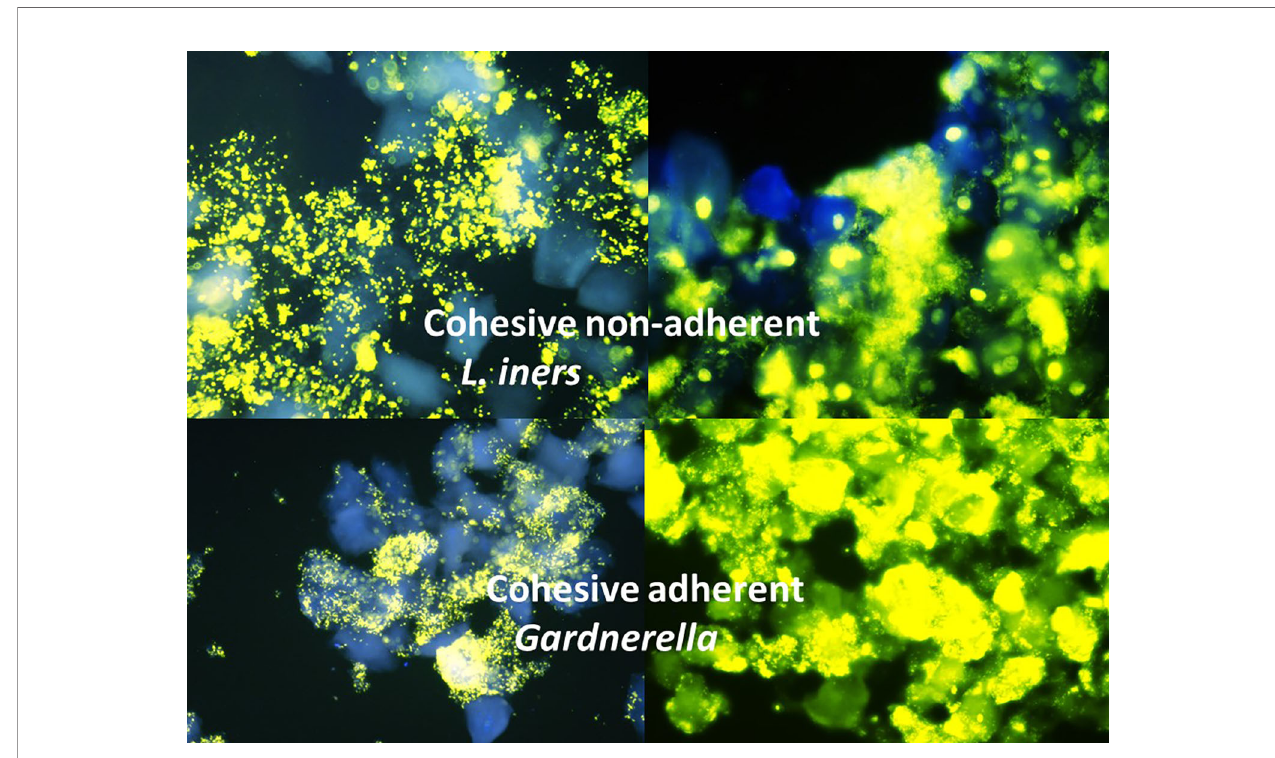
FIGURE 1 | Four examples of cohesive adherent ( Gardnerella with moderate and high density ) and cohesive non-adherent ( Lactobacillus iners with moderate and high density) spatial distribution of bacteria; C3 yellow fl uorescence against blue DAPI counterstain background, ×400.